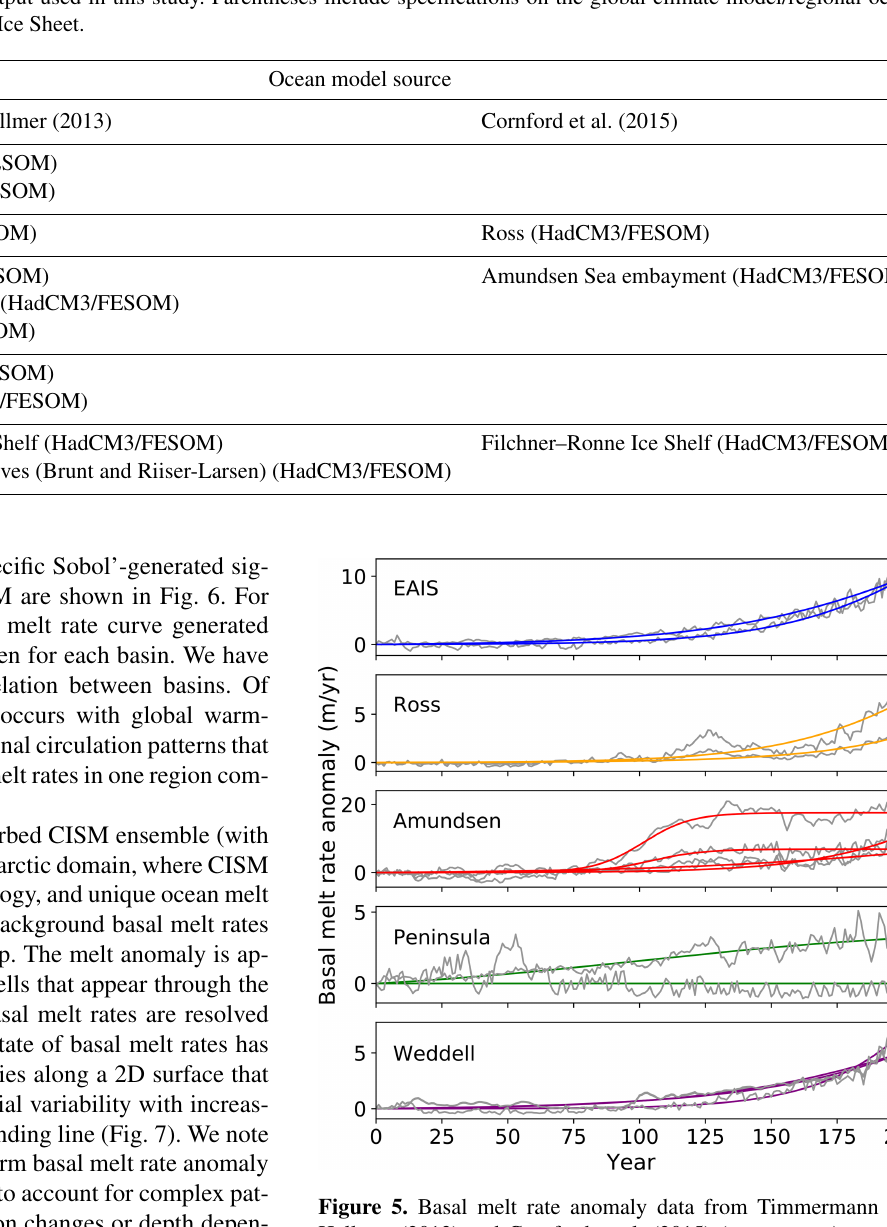
Figure 5. Basal melt rate anomaly data from Timmermann and Hellmer (2013) and Cornford et al. (2015) (grey curves) overlaid with best sigmoidal fits (colored curves). Colors correspond to the LARMIP regions in Fig. 4. Note the different y -axis range for each